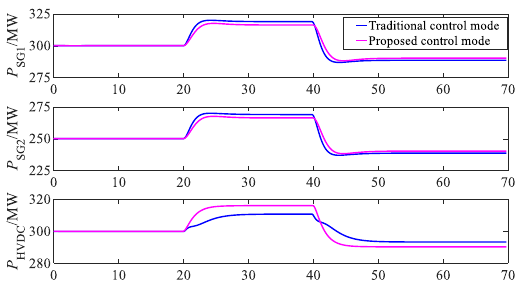
Figure 9. Output power of different sources in different control modes under sudden load changes.